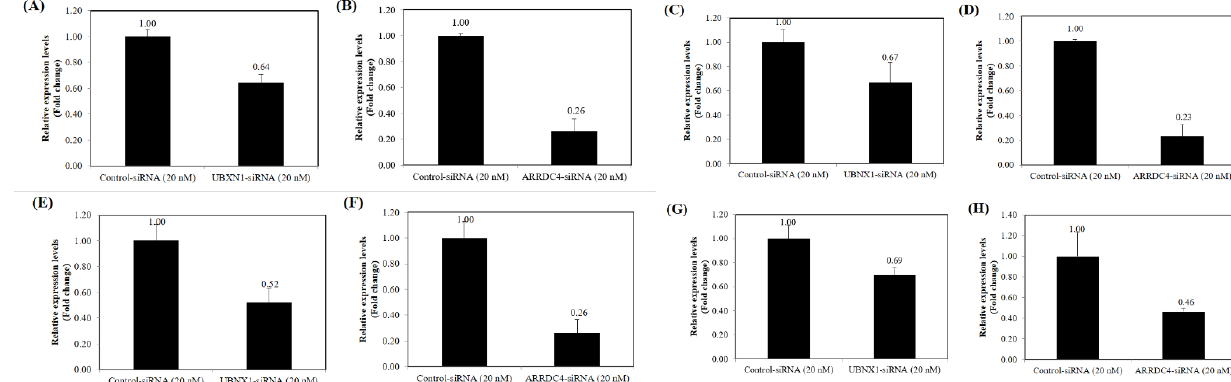
Figure 2. Effect siRNA transfection on UBXN1 and ARRDC4 expression. UBXN1 expression ( A ) and ARRDC4 expression